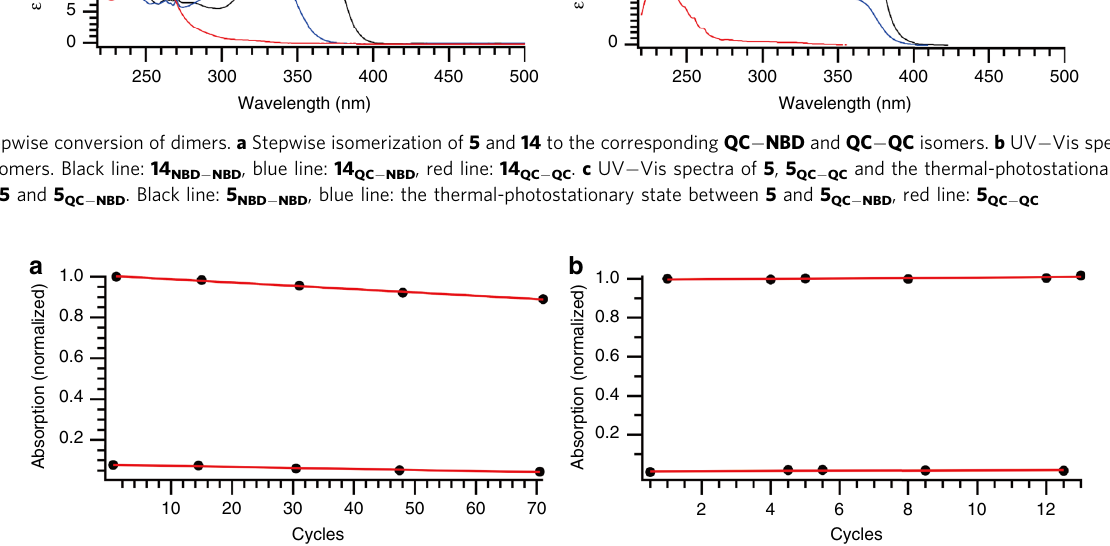
Fig. 7 Cyclability test. a Cyclability for 8 showing the normalized absorbance at 362 nm in cyclohexane at 50 °C irradiated at 365 nm. b Cyclability for 14 showing the normalized absorbance at 350 nm in cyclohexane at 70 °C irradiated at 340